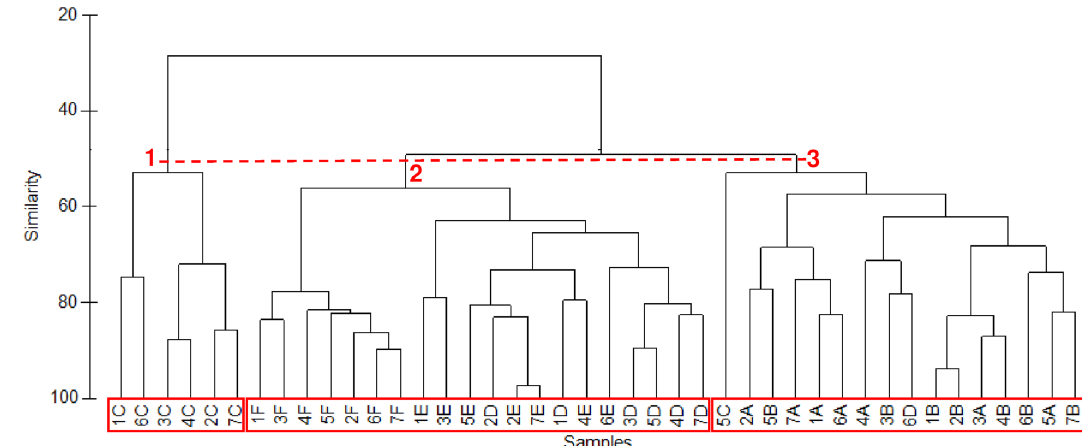
Figure 2. Dendrogram showing the spatial clustering of benthic macroinvertebrate communities between the six study sites (sites F–E–D are located above the weir and sites C–B-A are located below the weir, see Fig. 5) from May (1) to November (7), 2013.